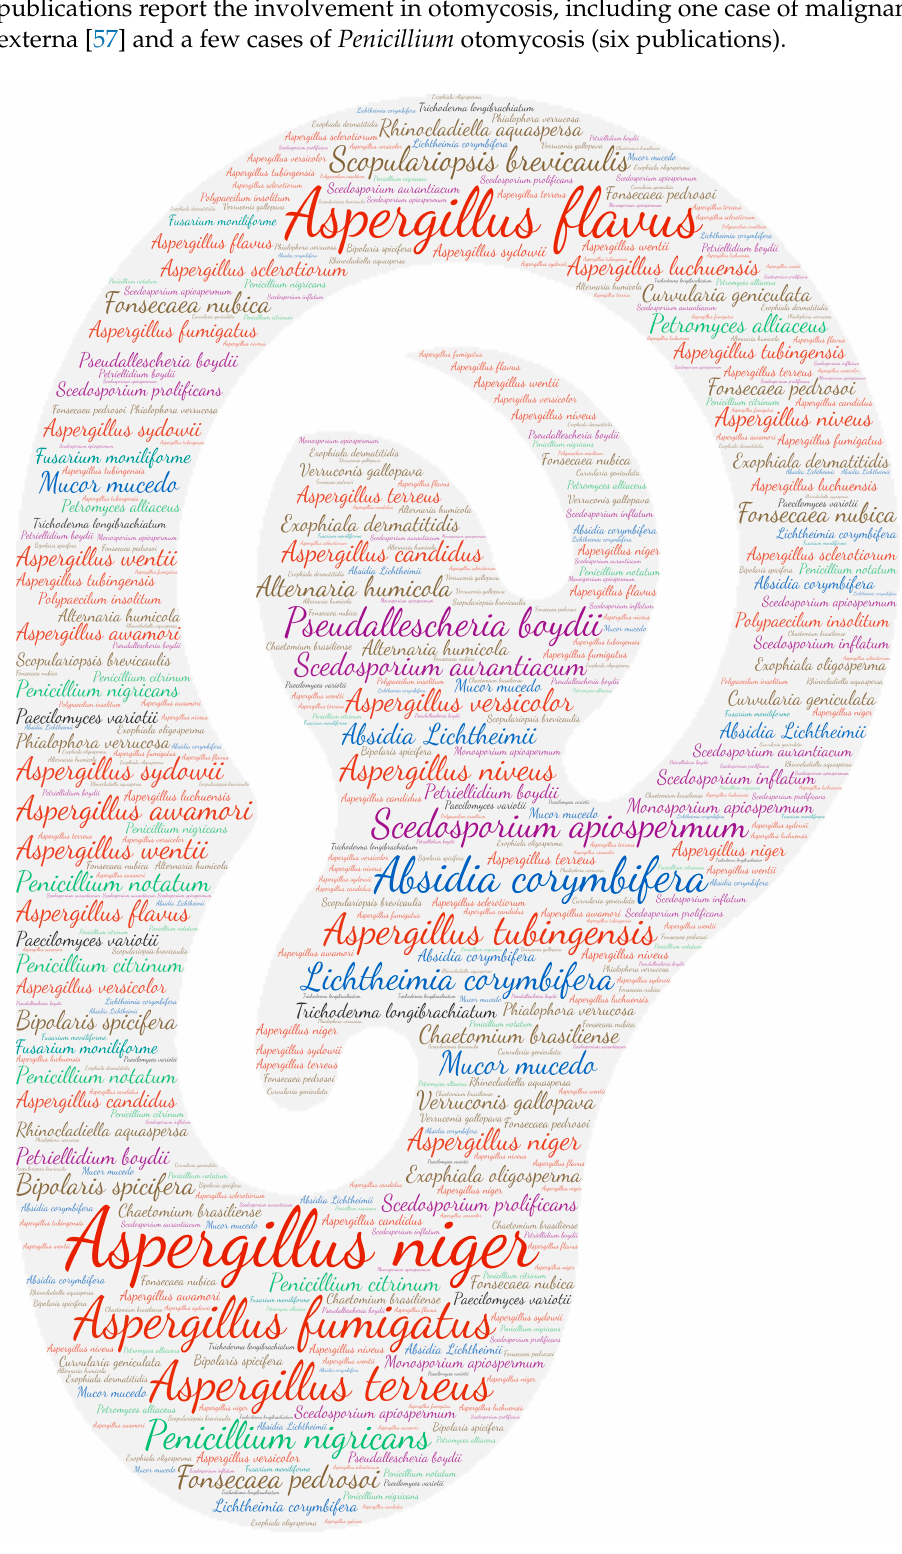
Figure 5. Wordcloud represents the species name isolated in the auditory system. The size of the name of each species is proportional to the number of times it occurs in the repertoire.